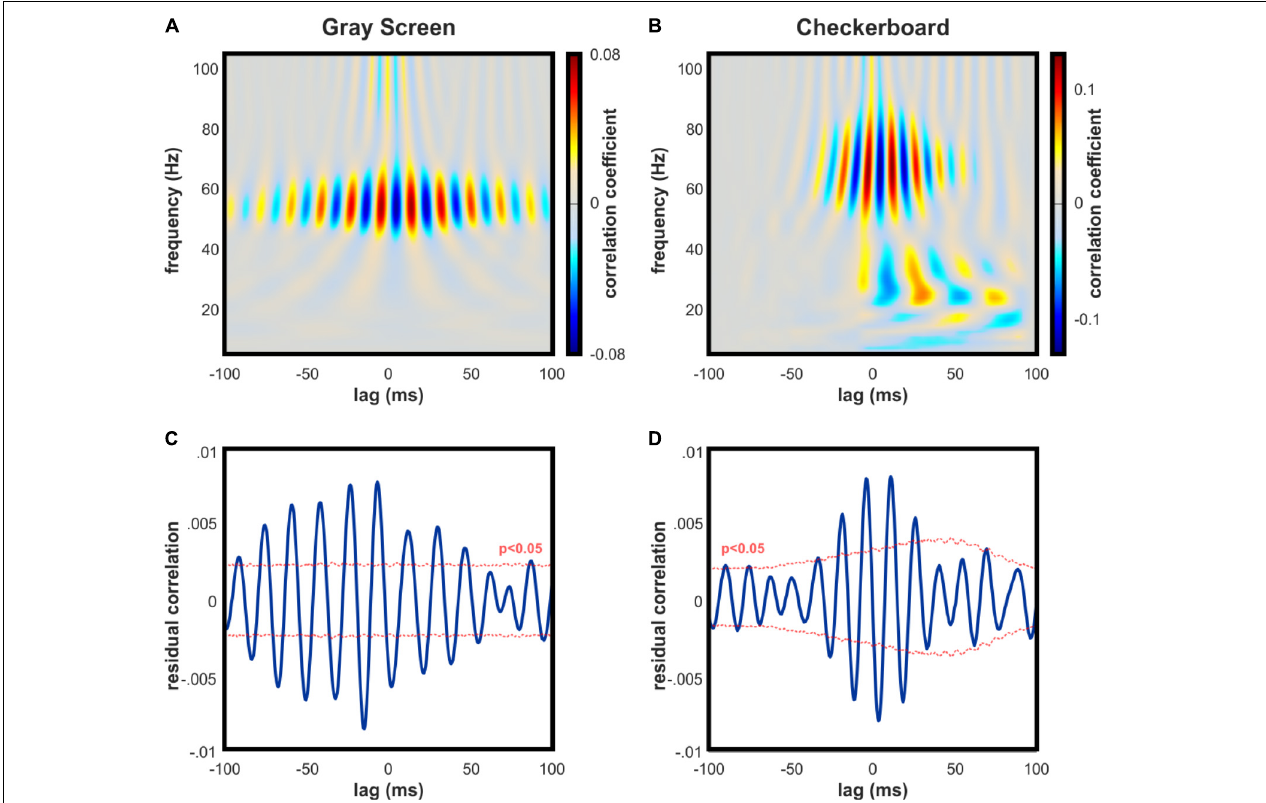
FIGURE 4 | Synchronization of spike activity in dLGN and V1 is strongly linked to both narrow and broadband high gamma in V1. (A) Example cross-correlation of dLGN-V1 spike synchrony and V1 LFP oscillations across frequency bands during gray screen viewing. Peak correlation occurs in the narrowband gamma frequency range. (B) Same as (A) for checkerboard viewing. Peak correlation exists across a broader frequency band, consistent with contrast-evoked broadband high gamma in V1. (C) Example statistical test for correlation between spike synchrony and bandpass-filtered high gamma in the V1 LFP (50–90 Hz) during gray screen viewing. Tested individually, significant peaks and troughs were detected in 5 of 6 animals. Thousand surrogates were generated by jittering dLGN spikes, and median surrogate values were subtracted for easier visual interpretation. (D) Same as C for checkerboard viewing. Tested individually, significant peaks and troughs were detected in all